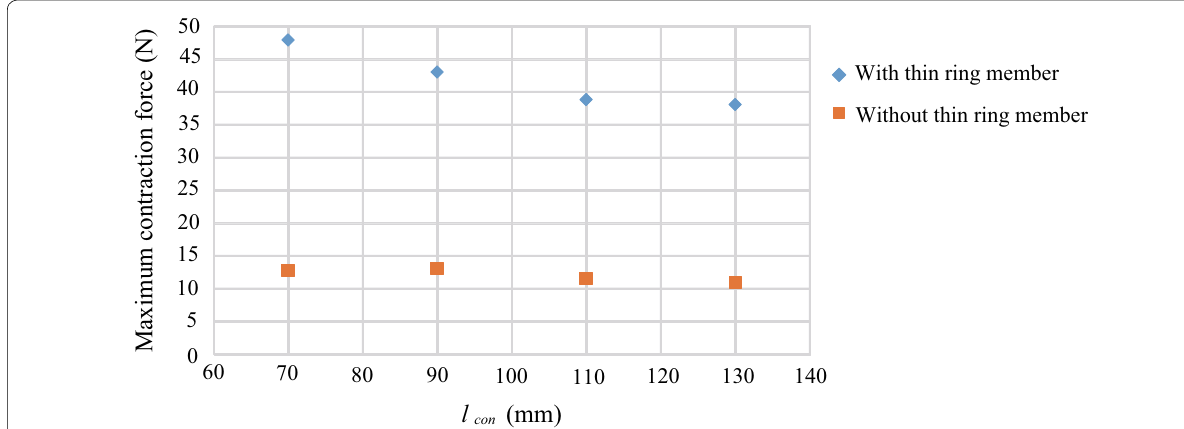
Fig. 37 Relation between distance l con (mm) and maximum contraction force (N) of the developed suction pad unit